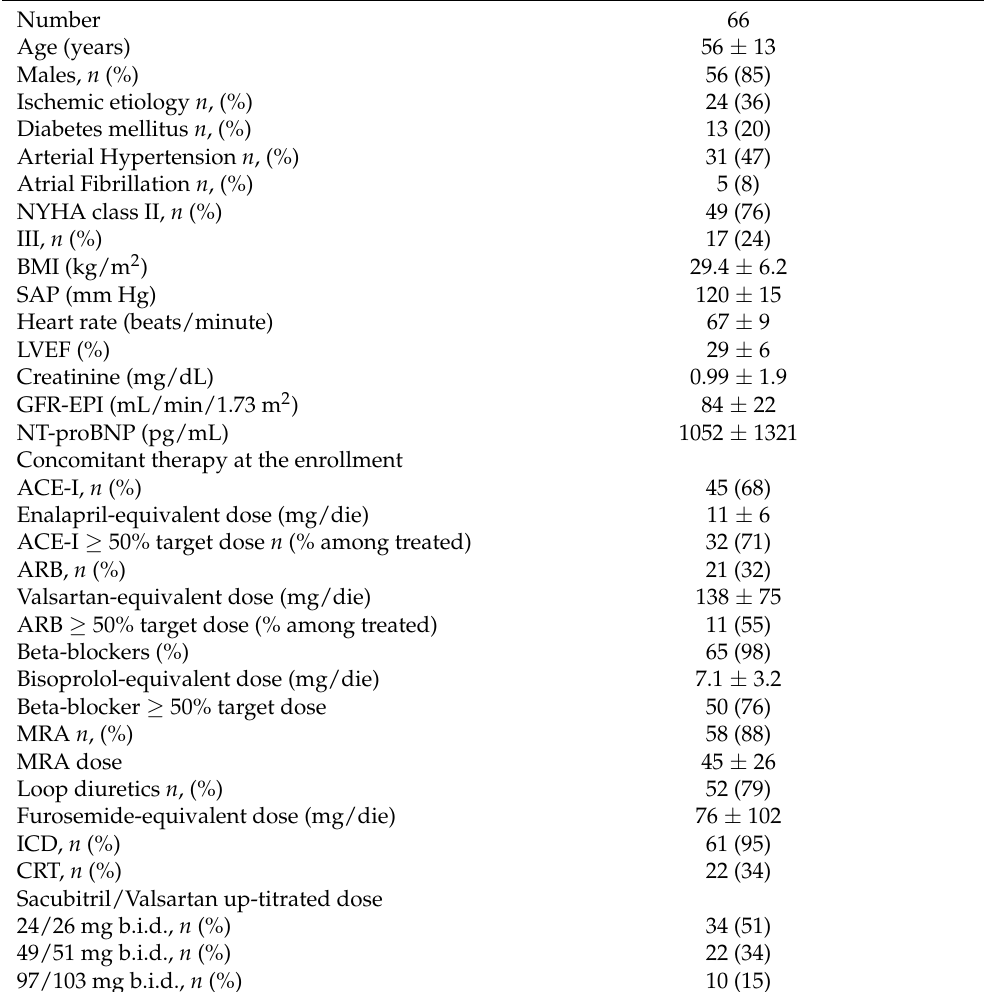
Table 1. Patient baseline clinical characteristics.